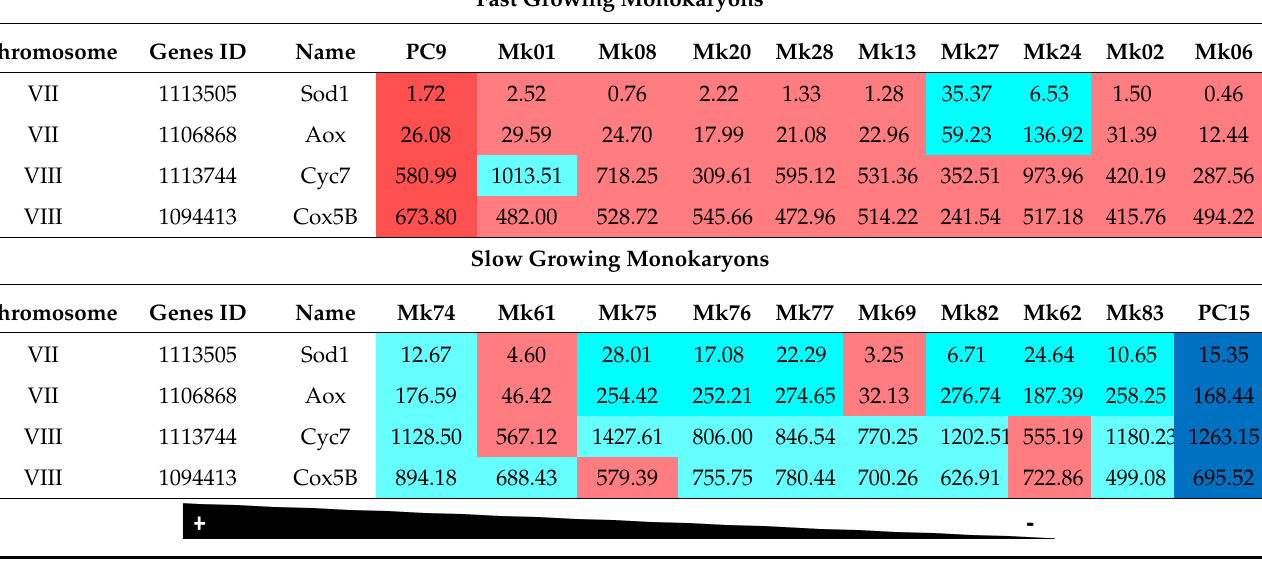
Table 1. Expression profile (RPKM) and parental origin allele of Sod1 , Aox , Cyc7 , and Cox5B genes. RPKMs were retrieved from RNA-seq data. MkPC9 (dark red) and MkPC15 (dark blue) are the parental protoclones. Light red (MkPC9 type) and blue (MkPC15 type) colors in fast- and slow-growing monokaryons indicate the origin of the parental allele in each monokaryon. Monokaryon growth rates ranged from the fastest to the slowest (indicated by the symbols + and -, respectively).